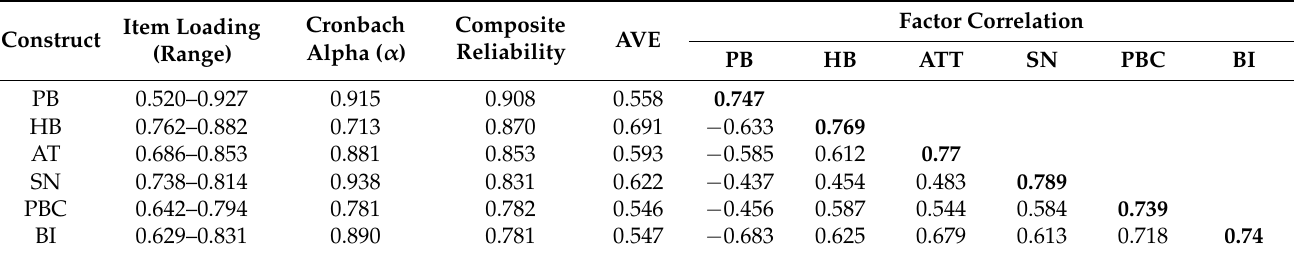
Table 4. The result of construct reliability, convergent validity, and discriminant